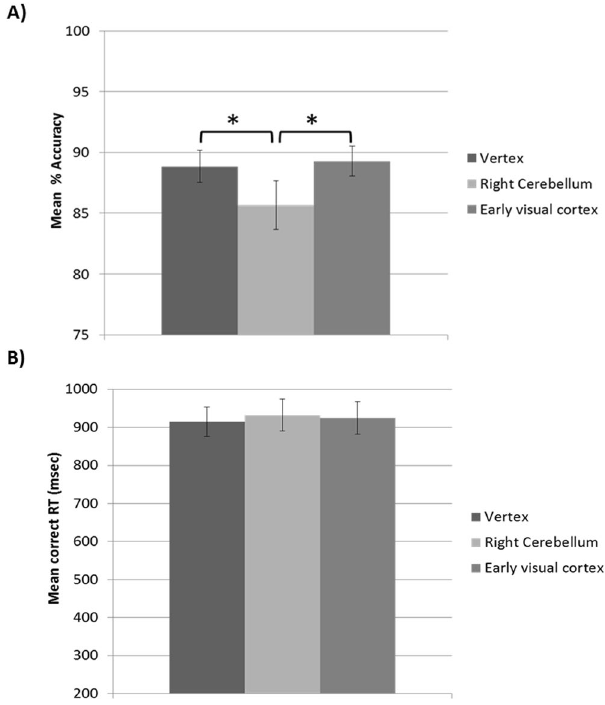
Figure 4. ( A ) Mean percentage accuracy scores and ( B ) mean correct RT as a function of TMS site (right cerebellum, early visual cortex and vertex) in Experiment 2. TMS over the cerebellum decreased participants’ accuracy rates compared to early visual cortex and vertex stimulation. TMS did not affect RT. Error bars represent ± SEM. Asterisks indicate significant differences between conditions ( * p <